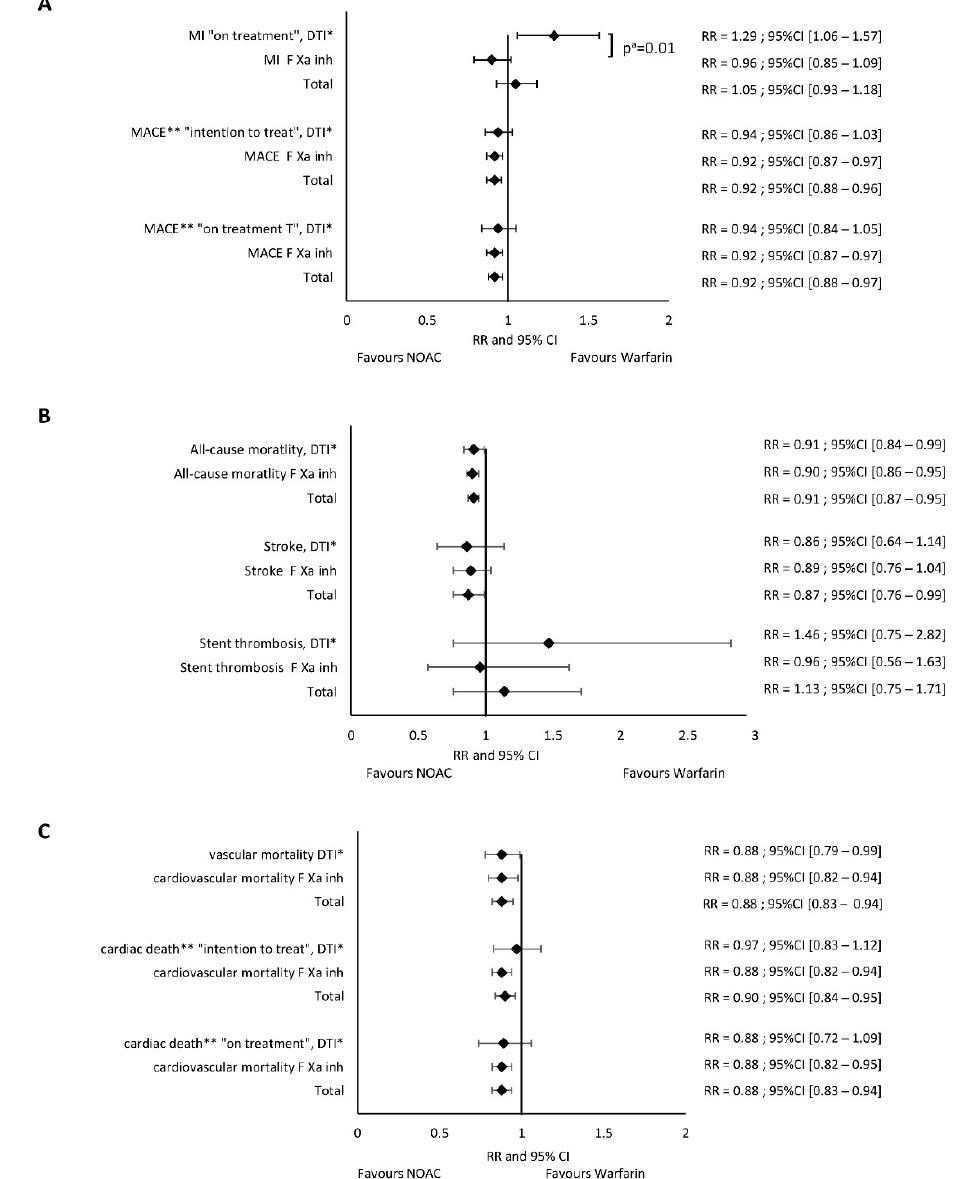
tary Figure S14A); NOACs, all together vs. warfarin (RR 0.91, 95% CI 0.88–0.96).